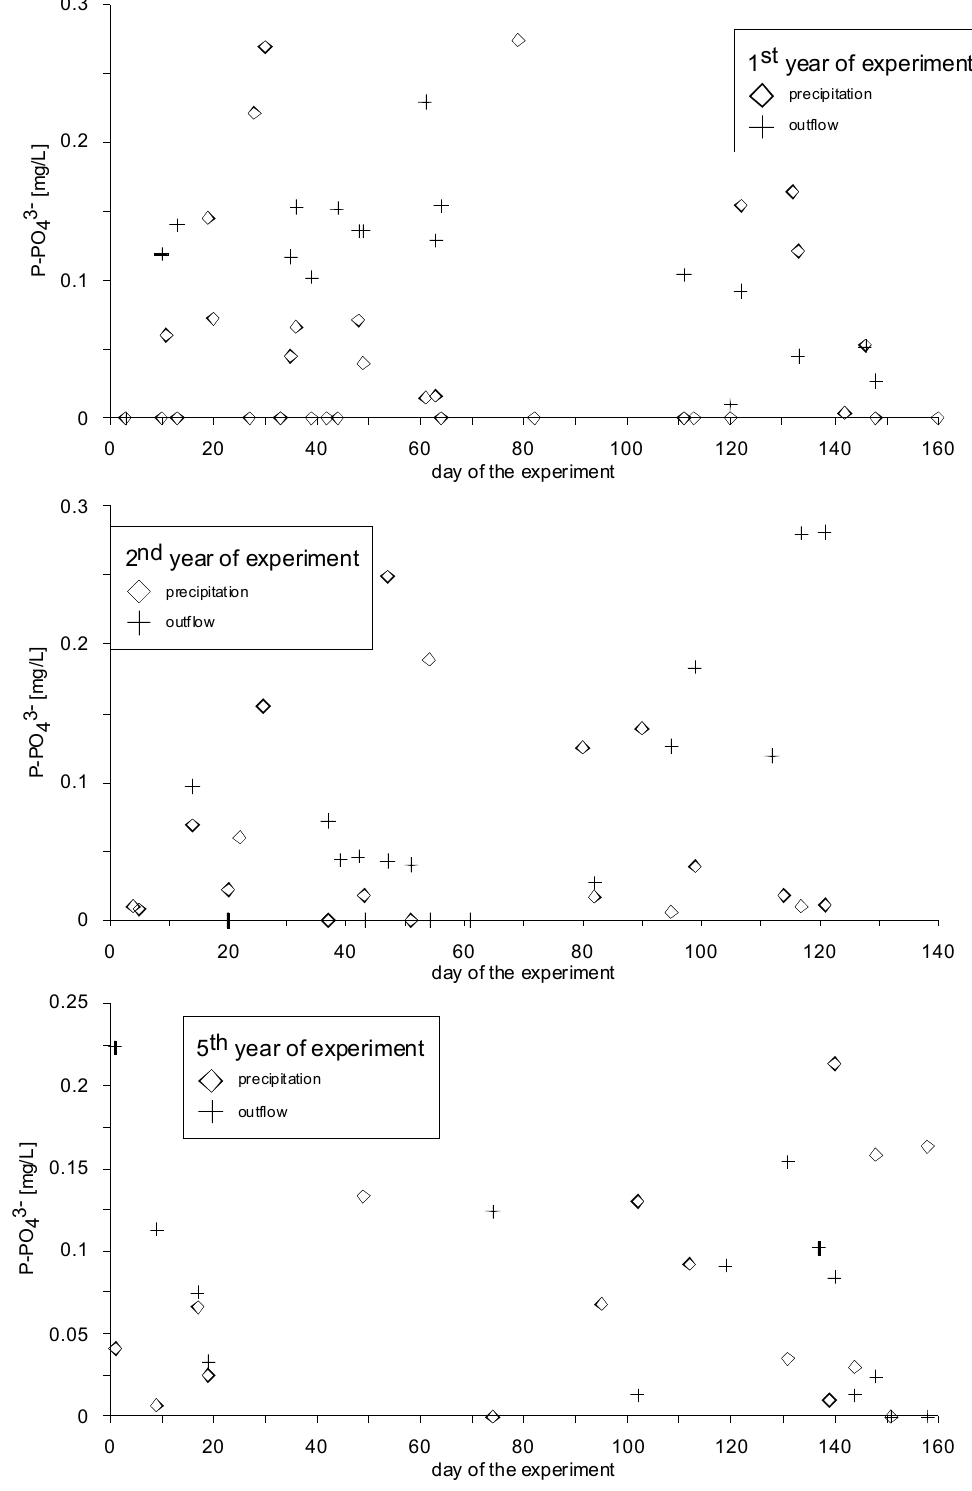
Figure 4. Concentration of P-PO 43 − in precipitation and leachates from substrate tested in long-term monitoring open air experiment.